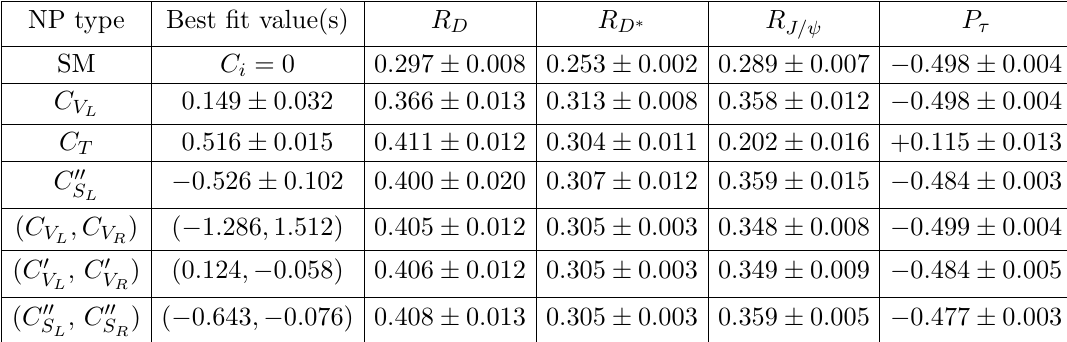
Table 4. Best (cid:12)t values of the coe(cid:14)cients of new physics operators at (cid:3) = 1 TeV by making use of data of R D , R D (cid:3) , R and P (cid:28) . Here we allow only those solutions for which (cid:31) 2 J= as Br ( B c ! (cid:28) (cid:22) (cid:23) ) < 0 : 1. We also provide the predictions of R D , R D (cid:3) , R